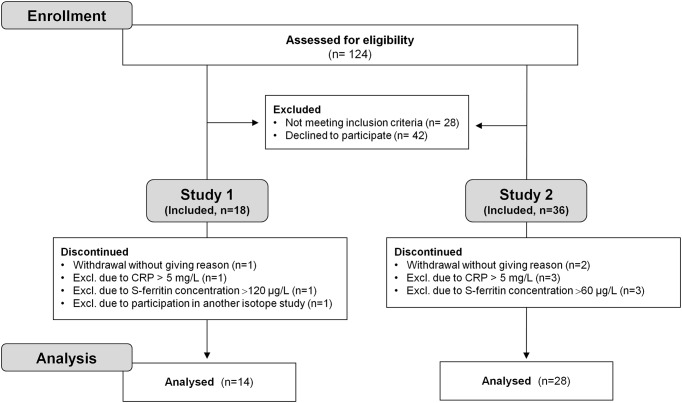
Study flowchart.